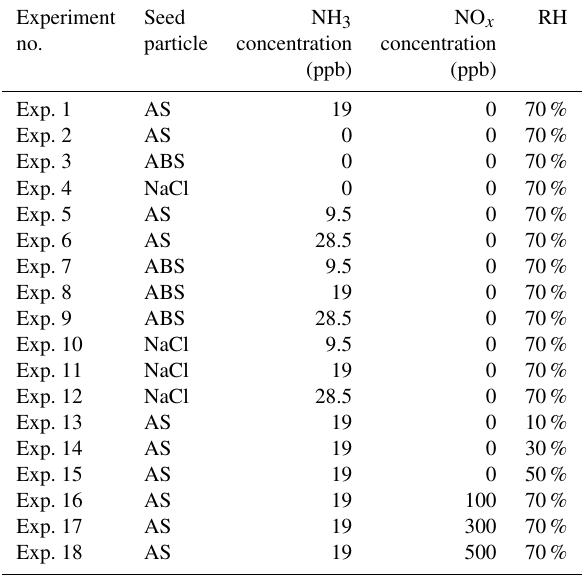
Table 1. Summary of experimental conditions.